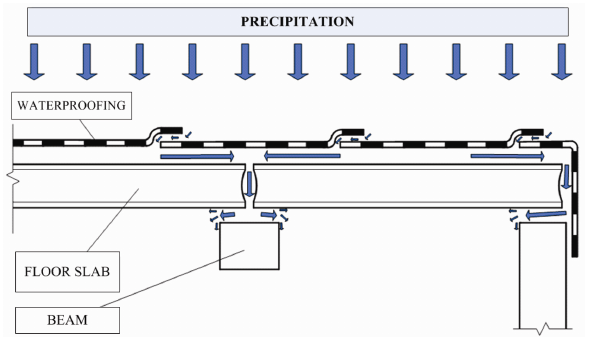
Fig. 15. Scheme of moisture entering the car